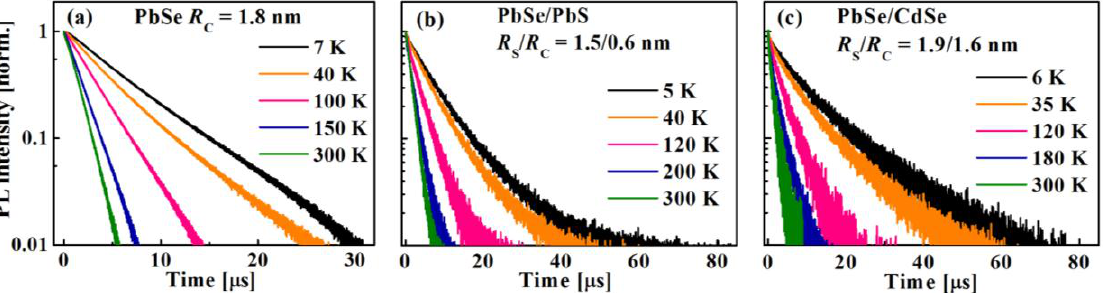
Figure 18. Representative time-resolved PL decay curves recorded at various temperatures for ( a ) PbSe; ( b ) PbSe/PbS; and ( c ) PbSe/CdSe QDs with different R s /R c values as indicated in the